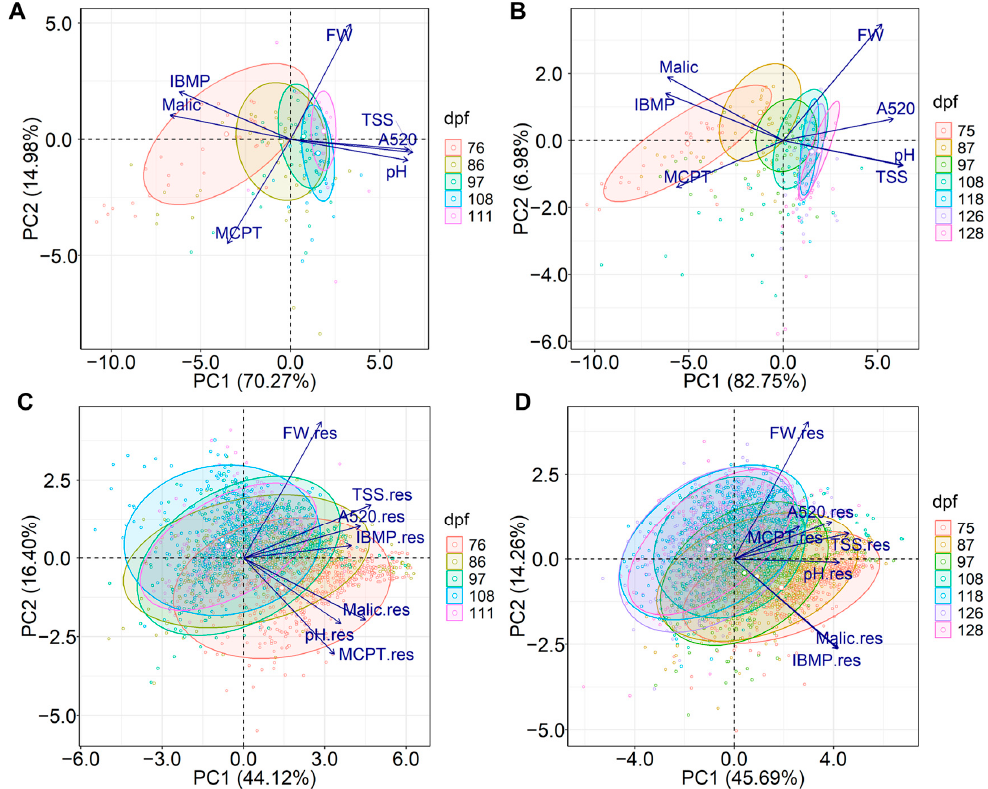
Figure 5. Biplots showing the fi rst two principal components (PC1 and PC2) for PCA of ( A , B ) aver- age values and ( C , D ) log of absolute residuals (res) for absorbance at 520 nm (A520), berry fresh weight (FW), 3-isobutyl-2-methoxypyrazine (IBMP), malic acid (malic), methyl cellulose precipitable (MCP) tannin, pH, and total soluble solids (TSS) grouped by sampling date (days-post-flowering, dpf) in 2019/2020 ( A , C ) and 2020/2021 ( B , D ).